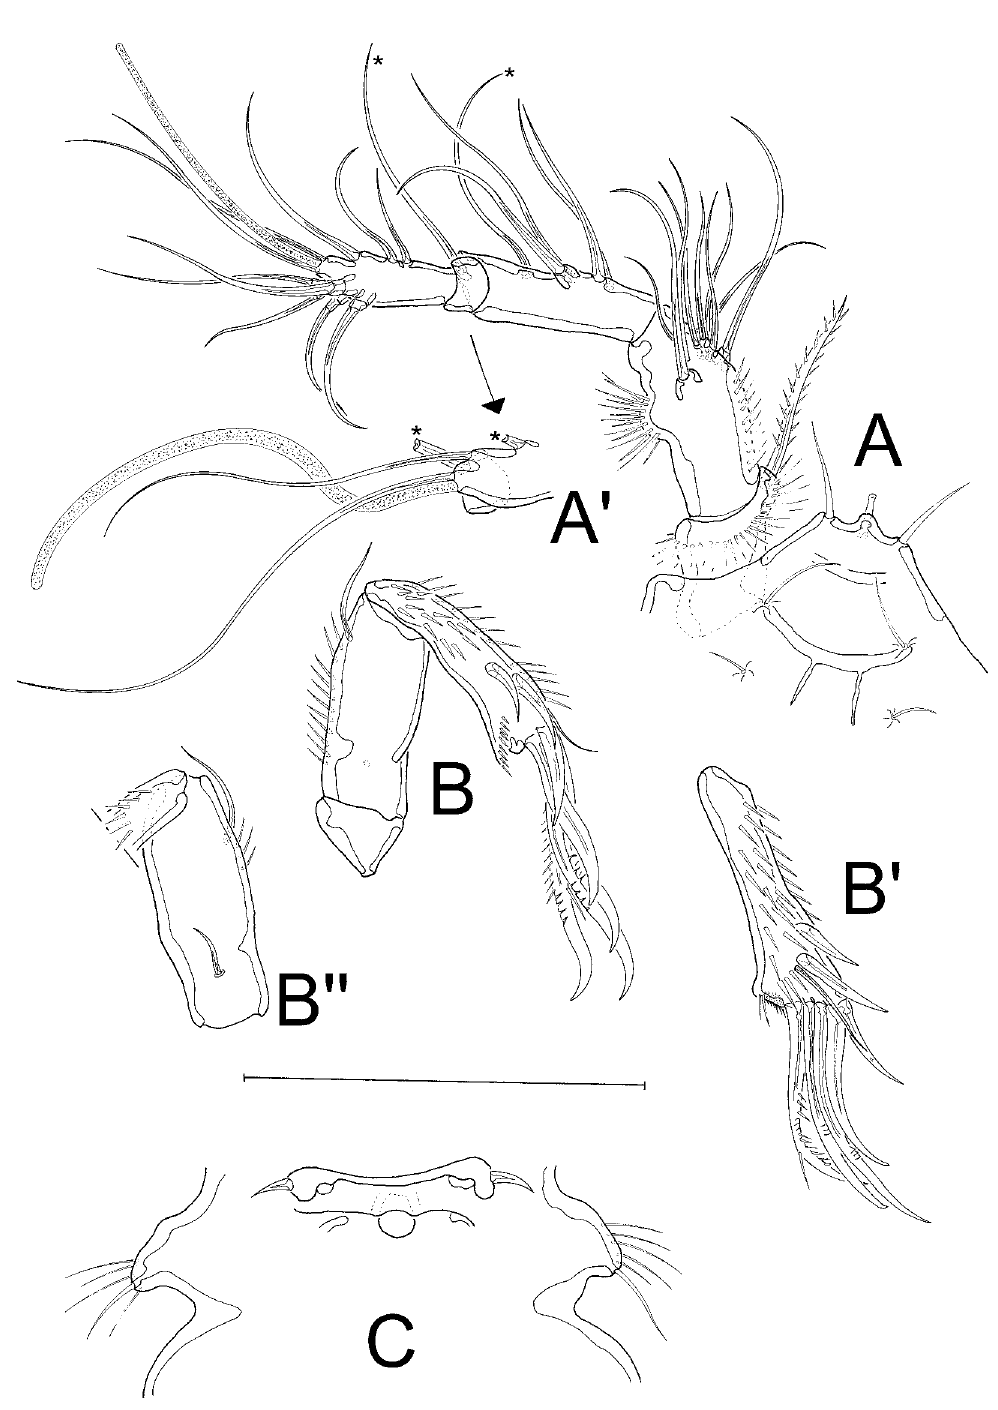
Fig. 13. Laophontodes gertraudae sp. nov., ♀. A . A1 and r (paratype SMF 37119/1). A’ . Detail of third segment of A1 (holotype, SMF 37114/1), asterisks (*) indicate corresponding setae. B . A2 (holotype, SMF 37114/1), dotted circle indicates position of exopodal seta. B ’. A2 allobasis (holotype, SMF 37114/1), drawn from counterpart. B” . A2 enp (paratype SMF 37117/1). C . GF with P6 (holotype, SMF 37114/1). Scale bar = 50